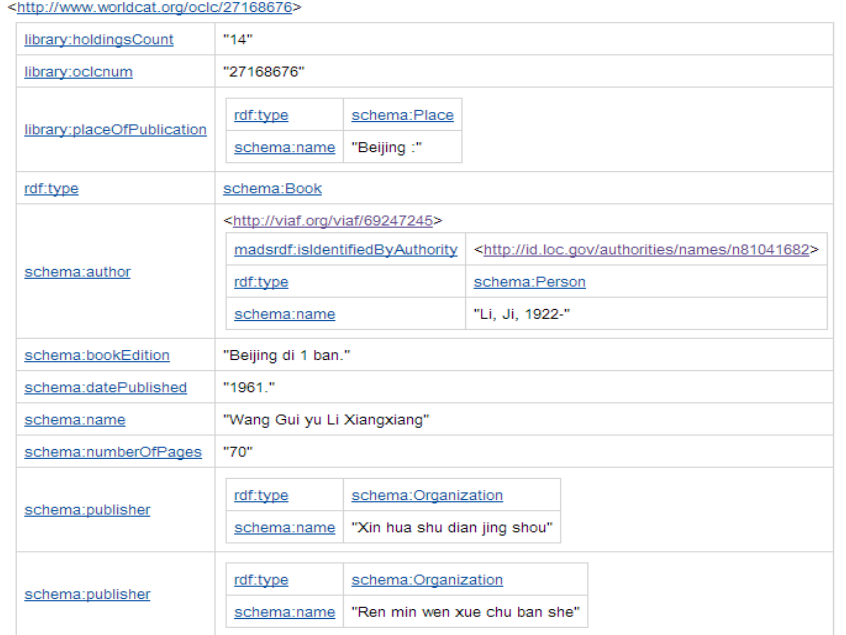
Figure 2. Human-readable display of a “record”.